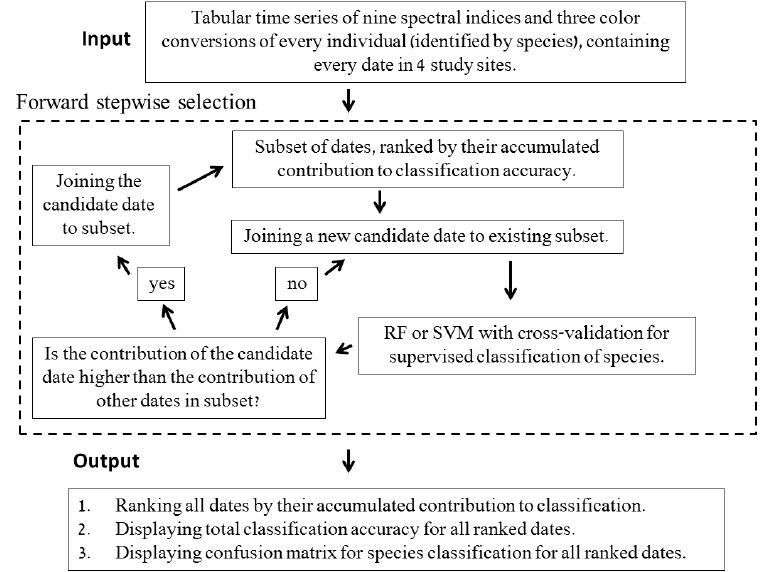
Figure 2. Feature selection process for selecting optimal acquisition times for classification on the basis of the near-surface time series.